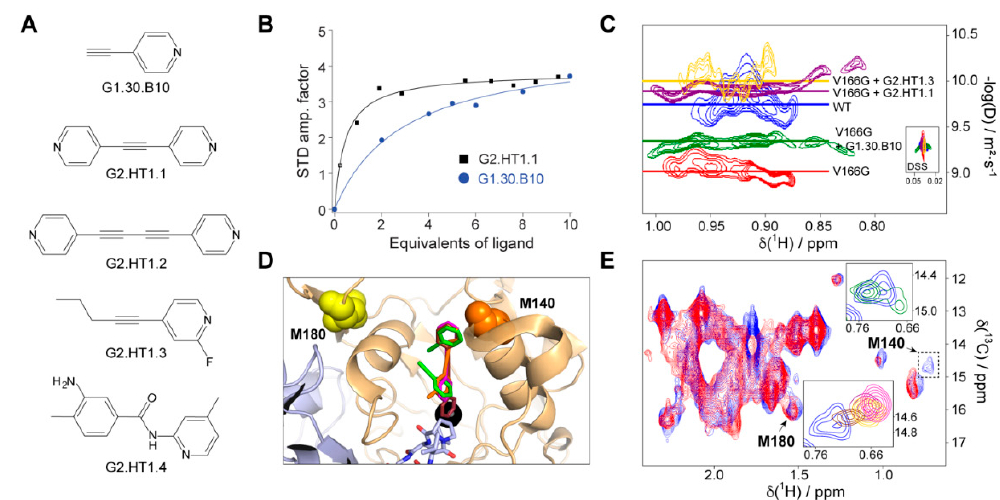
Figure 3. Inhibitors and chaperones found in this study. ( A ) Molecular formulas for the compounds under consideration. ( B ) Representative examples of the binding affinities as determined by saturation transfer difference spectroscopy. Blue cir- cles and black squares correspond to the experimental data for G1.30.B10 and G2.HT1.1, respectively. The solid lines reflect the best fitting of the experimental data to Equation (1). ( C ) Diffusion-ordered 2D NMR spectroscopy (DOSY) experiment performed on WT-FAH (blue), the unstable variant V166G-FAH (red), and the same protein in the presence of 10 eq. of G1.30.B10 (green), G2.HT1.1 (purple) or G2.HT1.3 (yellow). The diffusion coefficient is proportional to the molecular weight of the particle. ( D ) Structural model of the complex between FAH and a selected set of compounds including G1.30.B10 (blue), G2.HT1.2 (purple), and G2.HT1.3 (red). The longer compounds occupy both the active site and the approximation cavity, while G1.30.B10 independently binds to each of these sites. ( E ) Methionine methyl region of the 1 H, 13 C correlation spectrum and chemical shift perturbation in the presence of the compounds. Both insets correspond to M140, in the absence (light blue) and in the presence of compounds, using the same color code. Notice the signal splitting in the presence of G1.30.B10 (upper